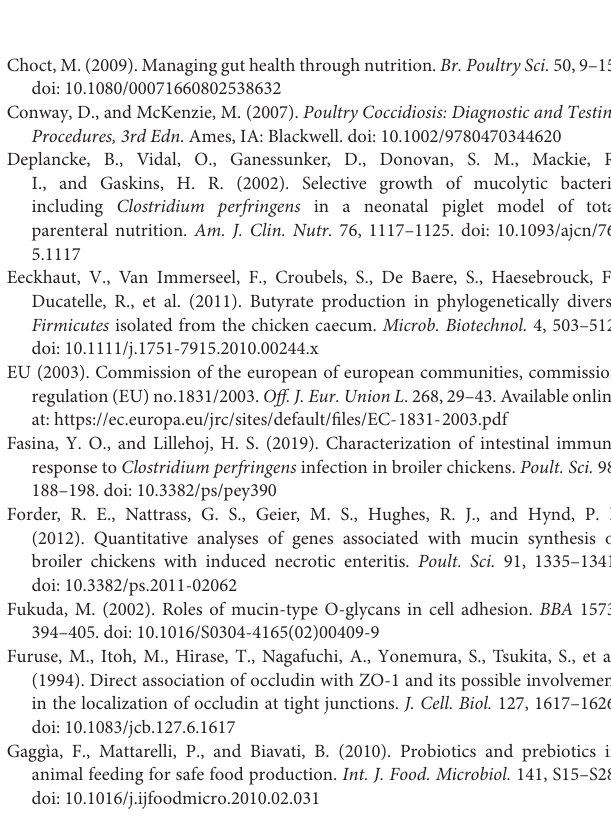
Supplementary Figure 1 | Effect of diet C. butyricum on the macroscopic and pathological section results. (A) NC. (B) PC. (C) NECB2. Supplementary Figure 2 | Effect of diet C. butyricum on the macroscopic and pathological section results. (A) E. max . (B) ECB. Red arrow: inflammatory cell infiltration; Blue arrow: eosinophils. Scale bar = 50 µ m. Supplementary Figure 3 | Effect of diet C. butyricum on E. maxima oocyst output. Each result represents the mean ± SEM ( n =